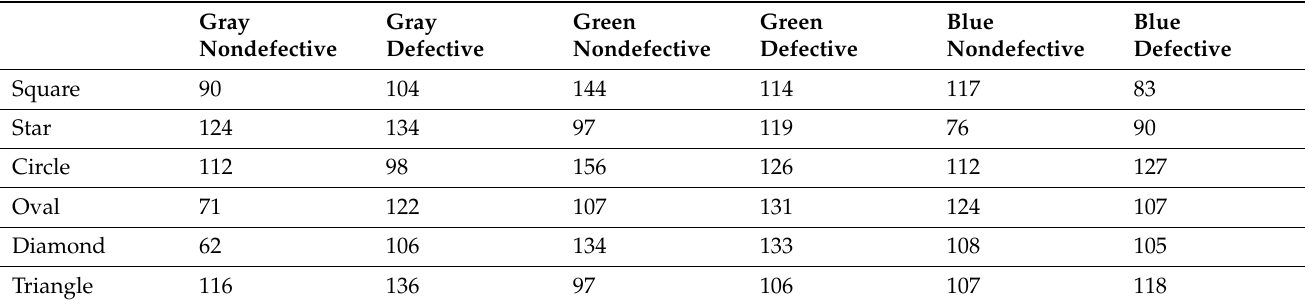
Table 2. Statistics of the dataset.